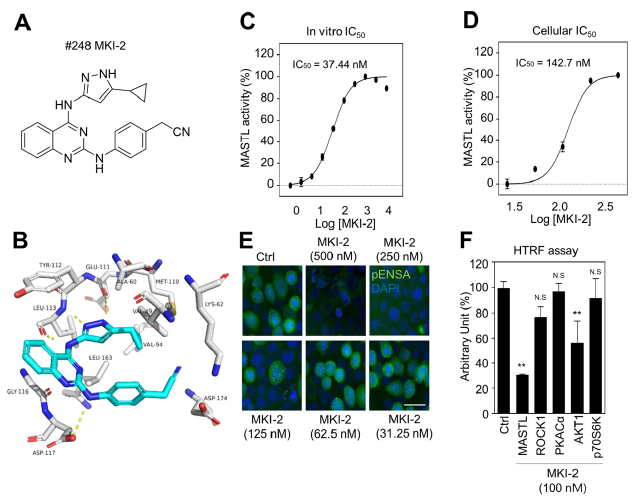
Figure 2. Validation of MASTL inhibitor MKI-2 using in silico and in vitro analyses ( A ) The chemical structure of MKI-2. ( B ) The docking model of MKI-2 and the MASTL kinase domain. The in vitro or cellular IC 50 of MKI-2 was determined by in vitro kinase assay ( C ) and the IN Cell Analyzer HCA System ( D ). In at least 4 images, each image that contains more than 500 cells was analyzed from each group by the IN Cell analyzer. ( D , E ) Immunofluorescence staining was performed using anti- phospho(Ser67) ENSA (green) in MCF7 cells after arrested in mitosis using colcemide (80 ng/mL) and various concentrations of MKI-2 for 14 h. Scale bars = 20 µ m. ( F ) HTRF kinase assay were performed using recombinant AGC kinases to determine AGC kinases activities with 100 nM MKI-2. The data are presented as the mean ± standard deviation of three independent experiments. ** p < 0.01. n.s.: not significant. 2.2. MKI-2 Induces Mitotic Catastrophe of Breast Cancer Cells via MASTL-PP2A whether MKI-2 inhibits phospho-ENSA in three breast cancer cell lines, including MCF7, BT549, and MDA-MB468 cells. Our data indicated that MKI-2 inhibited phosphorylated- ENSA in the three breast cancer cell lines (Figure 3A). In addition, we examined whether MKI-2 increases PP2A activity and inhibits c-Myc since we previously observed that MASTL inhibition activates PP2A and decreases c-Myc stability in breast cancer cells [12,22]. Forskolin and OA were used as positive and negative controls in the PP2A activity assay, respectively. Our data indicated that MKI-2 can increase PP2A activity and de- crease c-Myc proteins (Figure 3A, B), suggesting that MKI-2 inhibits the MASTL-PP2A-c- Myc axis in breast cancer cells.